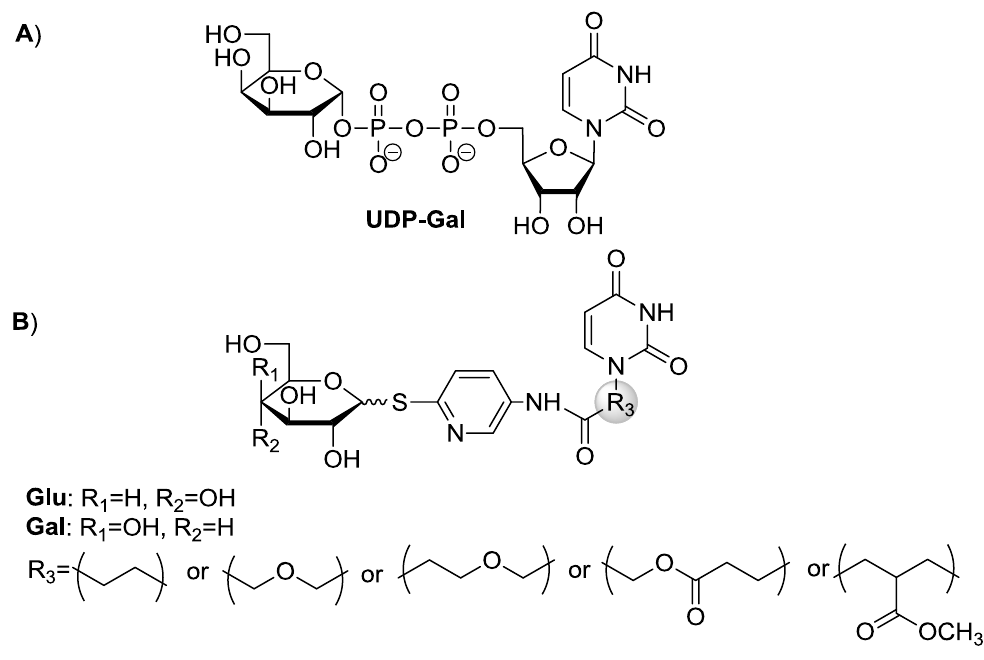
Figure 1. ( A ) Natural GTs substrate; ( B ) structures of synthesised GTs